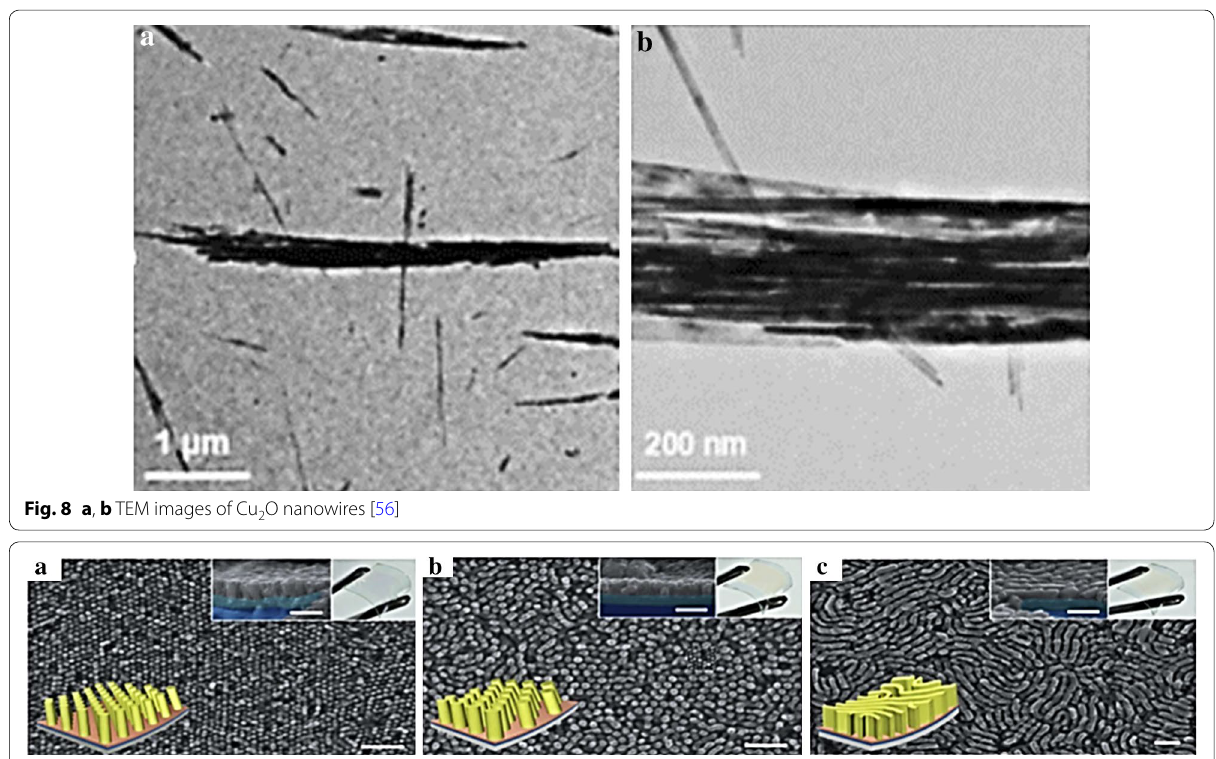
Fig. 9 a – c FE-SEM images of ZnO nanorods grown from different templates. The yellow schematic images show the pore size of each template. Inset images show the side view and the flexible substrate held by tweezers